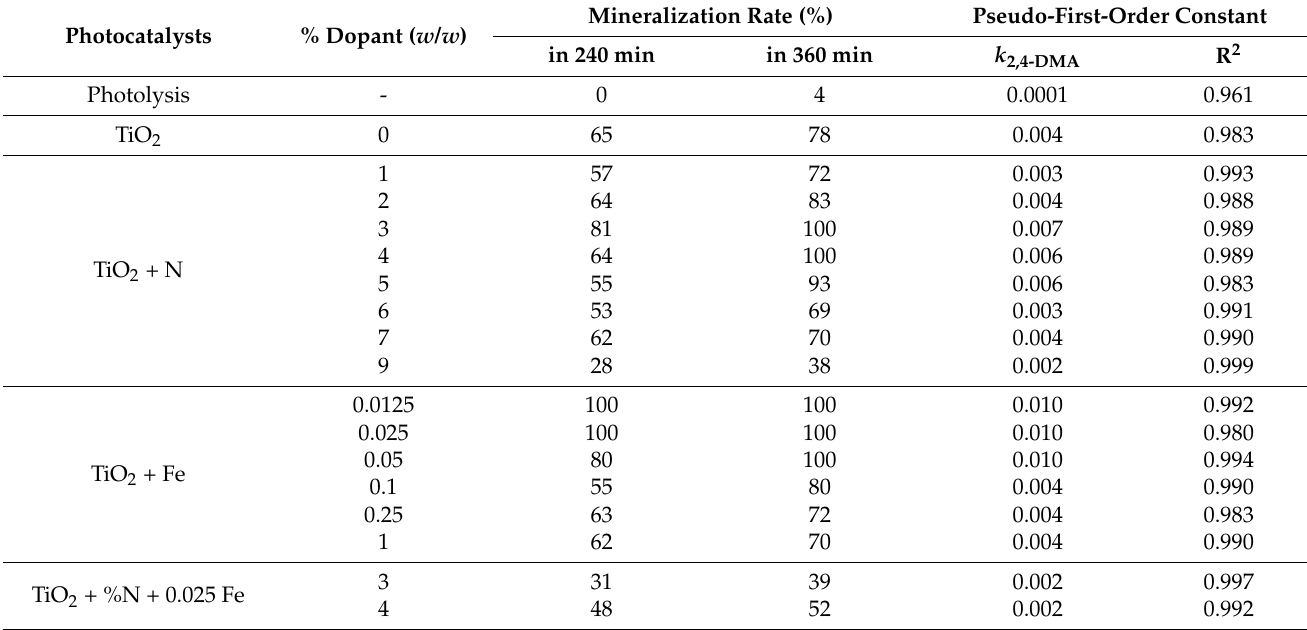
Table 4. Removal percentage mineralization and pseudo-first-order